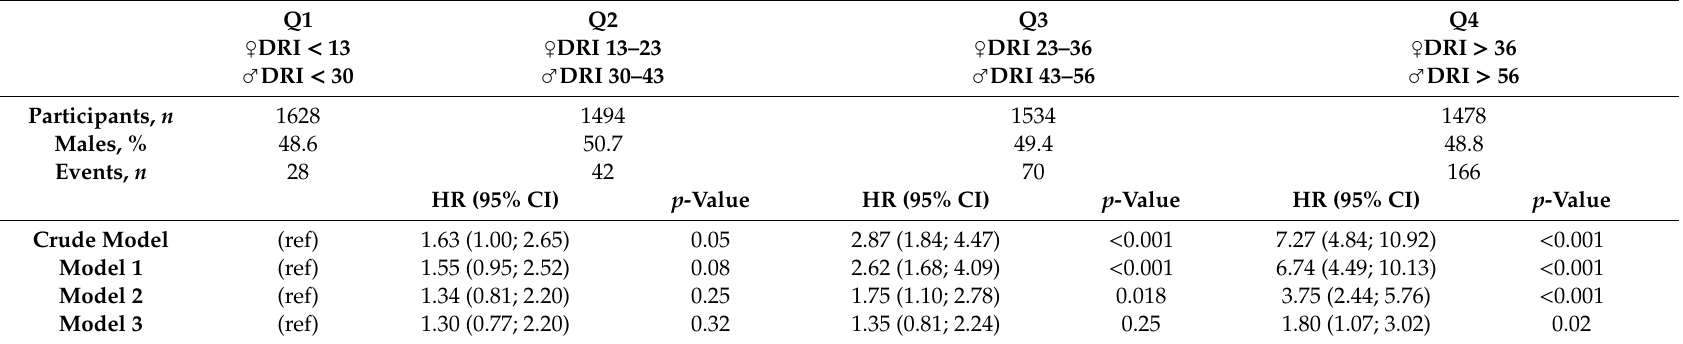
Table 3. Association of DRI scores with incident T2DM by sex-stratified quartiles in the PREVEND study ( n =